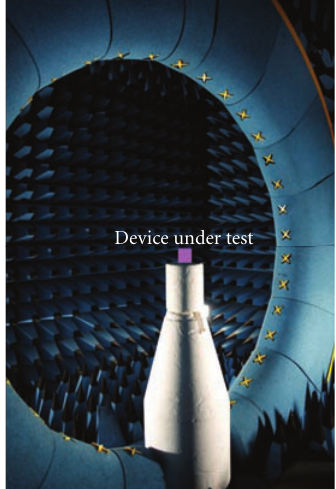
F 6: Anechoic chamber having a gate with 31 probes